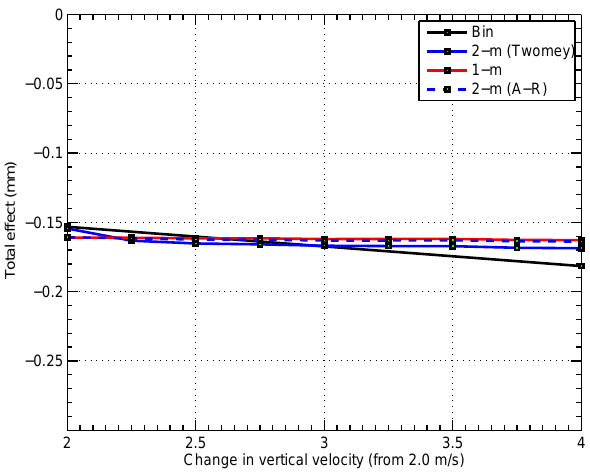
Fig. 13. As Fig. 12 but for changes in w 1 starting from 2ms − 1 .